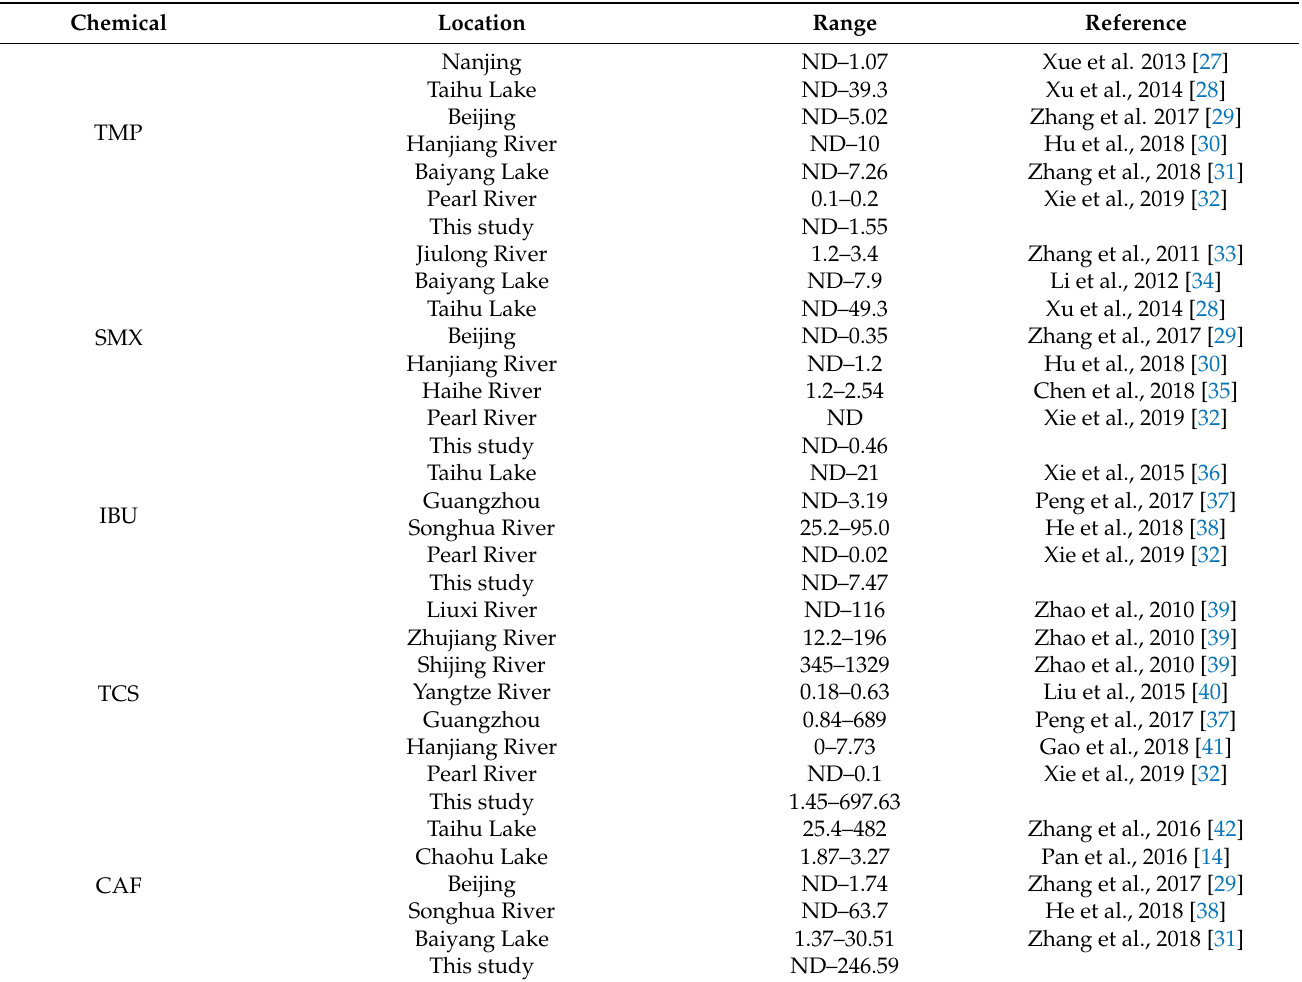
Table 1. Occurrence and concentration of PPCPs in sediments in different study areas ( µ